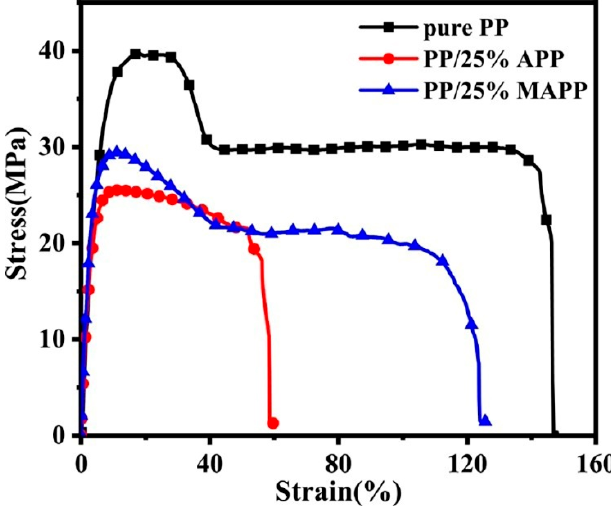
Figure 13. Typical stress-strain curves of pure PP and its flame-retardant blends. Table 5. Mechanical properties data of pure PP and its flame-retardant blends.